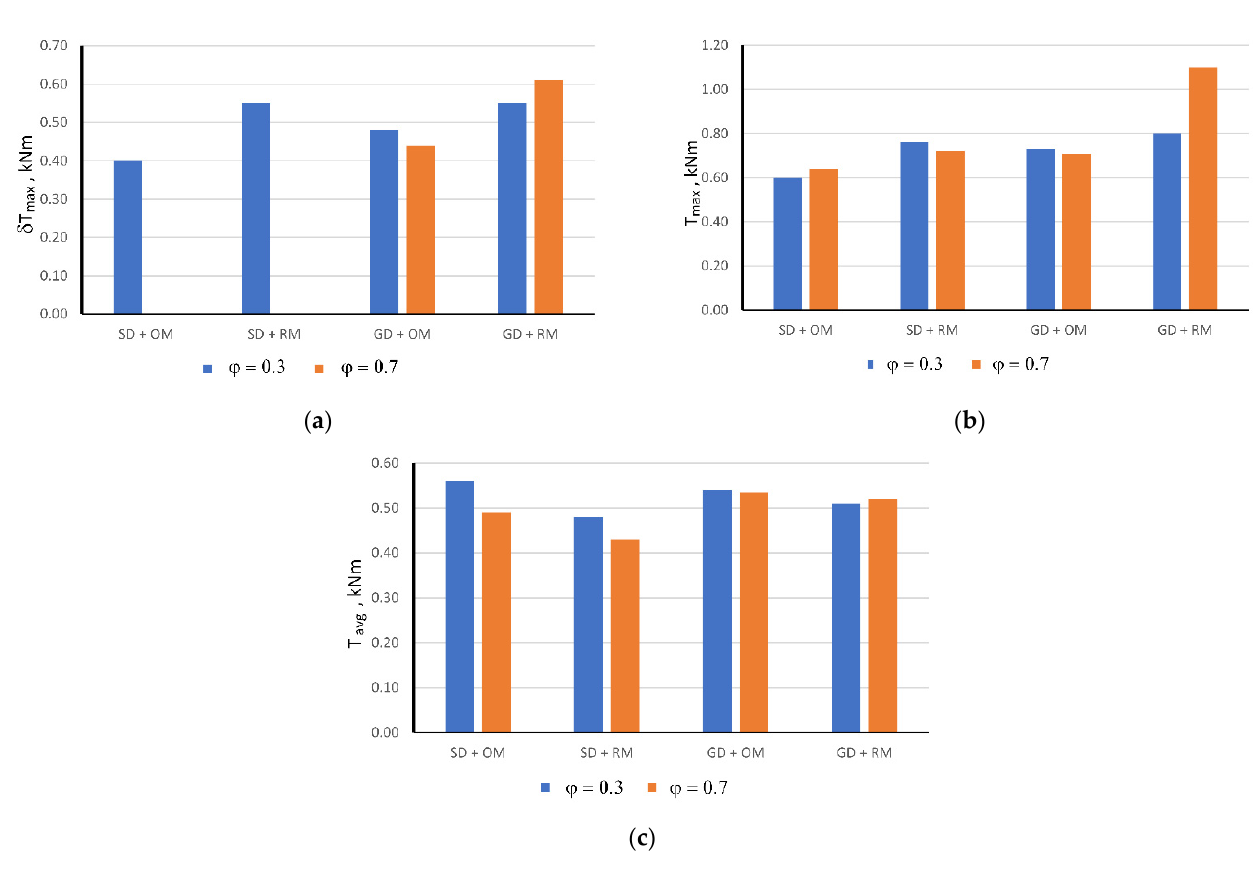
Figure 19. List of the values of the maximum differences in moments ( a ), maximum moments ( b ), and the values of the average moments ( c ) when the vehicle model was driven through the ditch at different maximum values of the coefficient of adhesion: GD—gear-type flow divider, SD—spool-type flow divider, OM—orbital motor, RM—radial piston motor.